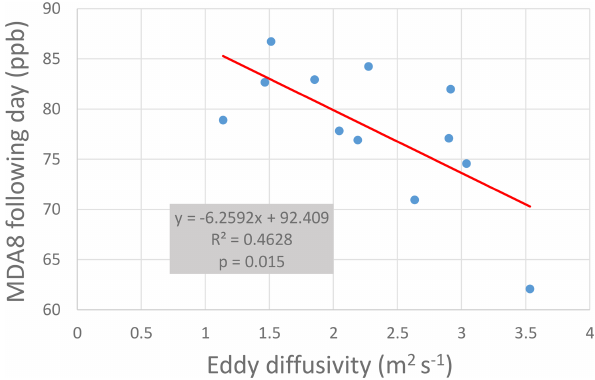
Figure 10. Correlation between overnight eddy diffusivity and max- imum daily 8h average ozone (MDA8) the following day. All values are averages of 11 CARB surface network stations that are within the flight